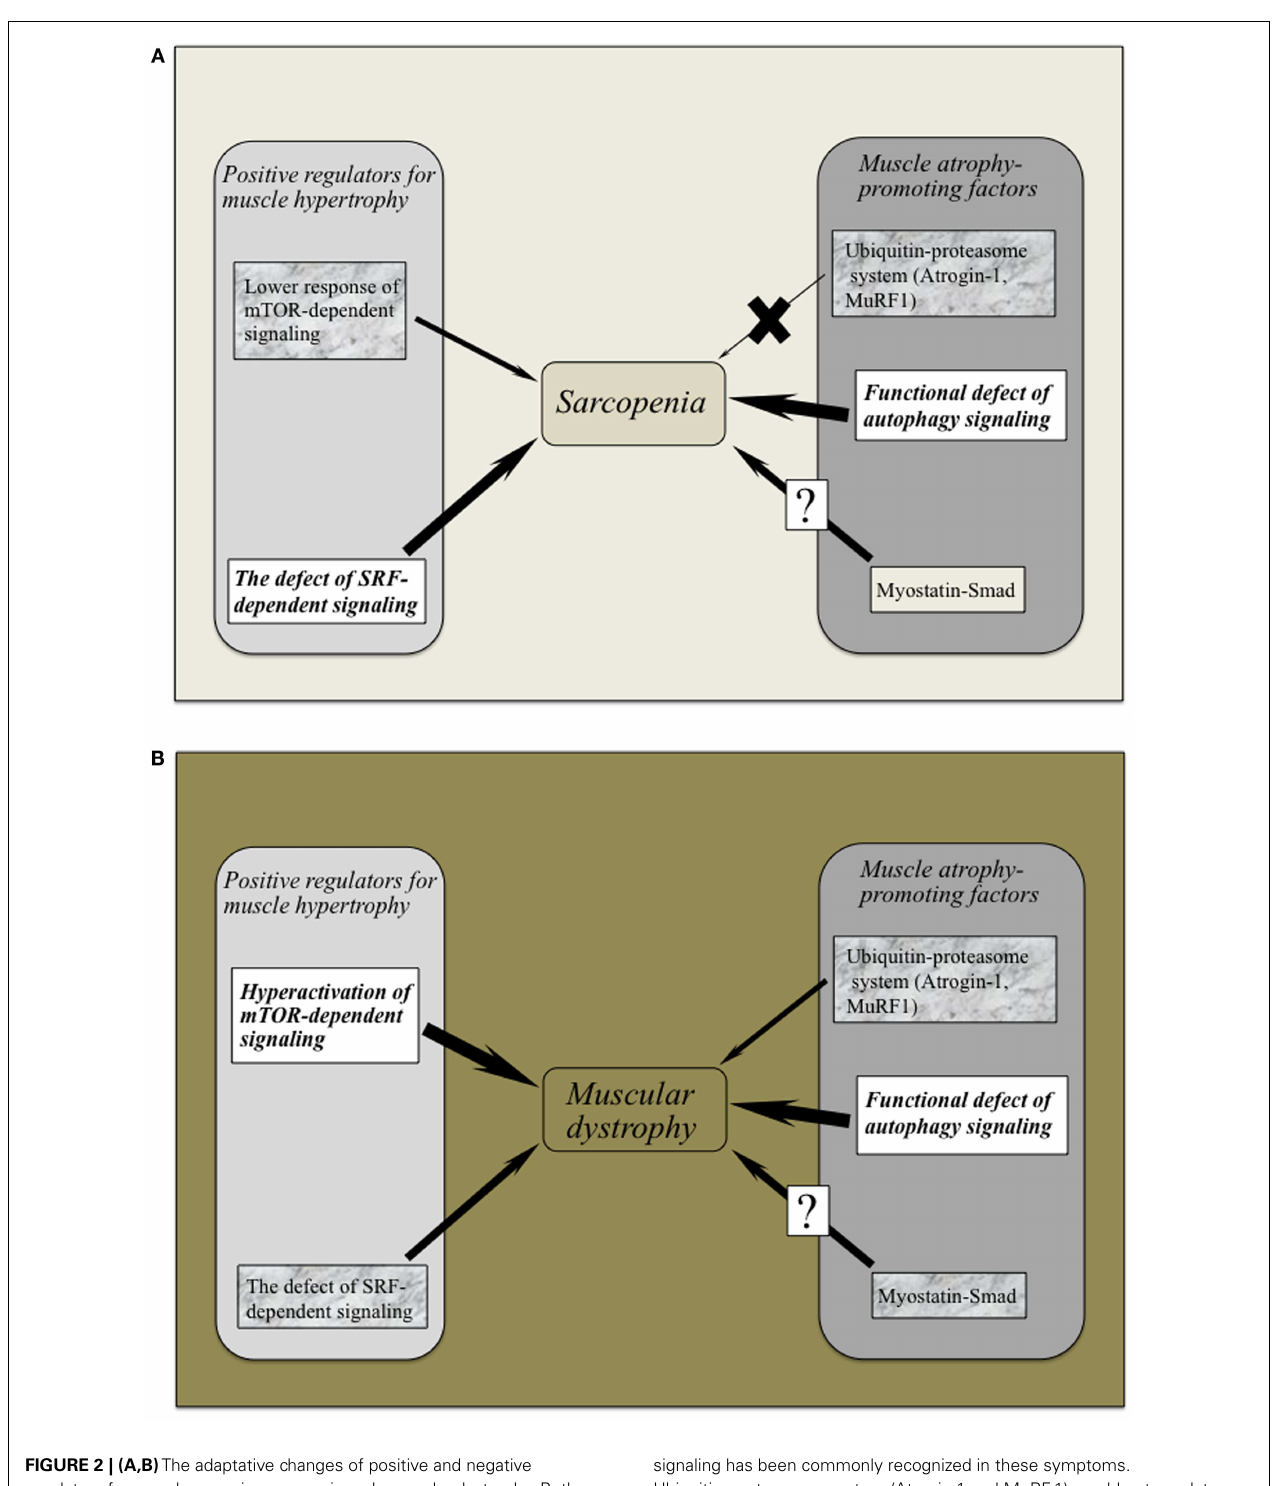
FIGURE 2 | (A,B) The adaptative changes of positive and negative regulators for muscle mass in sarcopenia and muscular dystrophy. Both sarcopenia and muscular dystrophy exhibit the marked defect of autophagy-dependent signaling possibly the latter due to hyperactivation of Akt/mTOR/p70S6K pathway. Lower activation of SRF-dependent